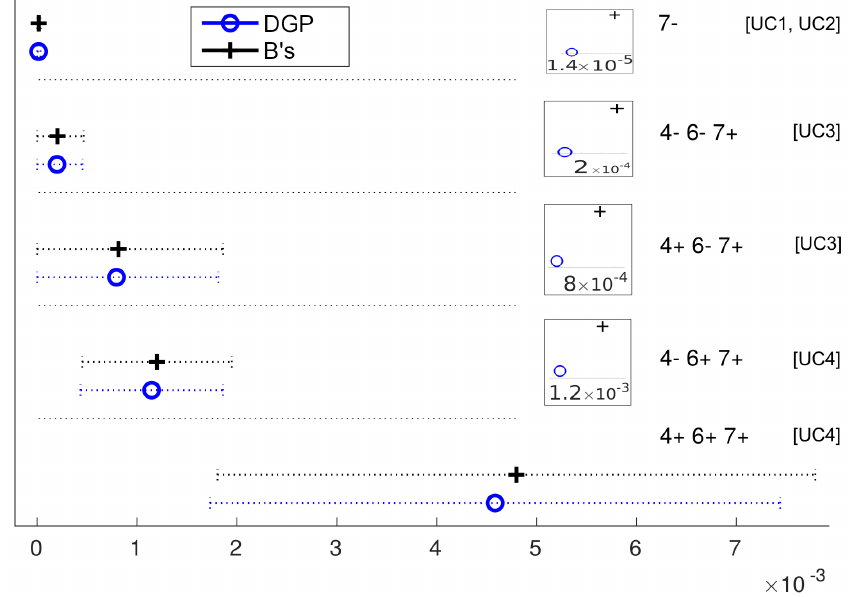
Figure A8. The five distinctive behaviours found in all scenarios for M 11 ( α R − uncert ), with zoom in those with more similar measure for both